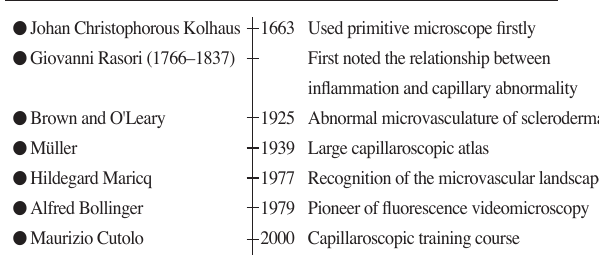
Table 1. A simple history of nailfold capillaroscope